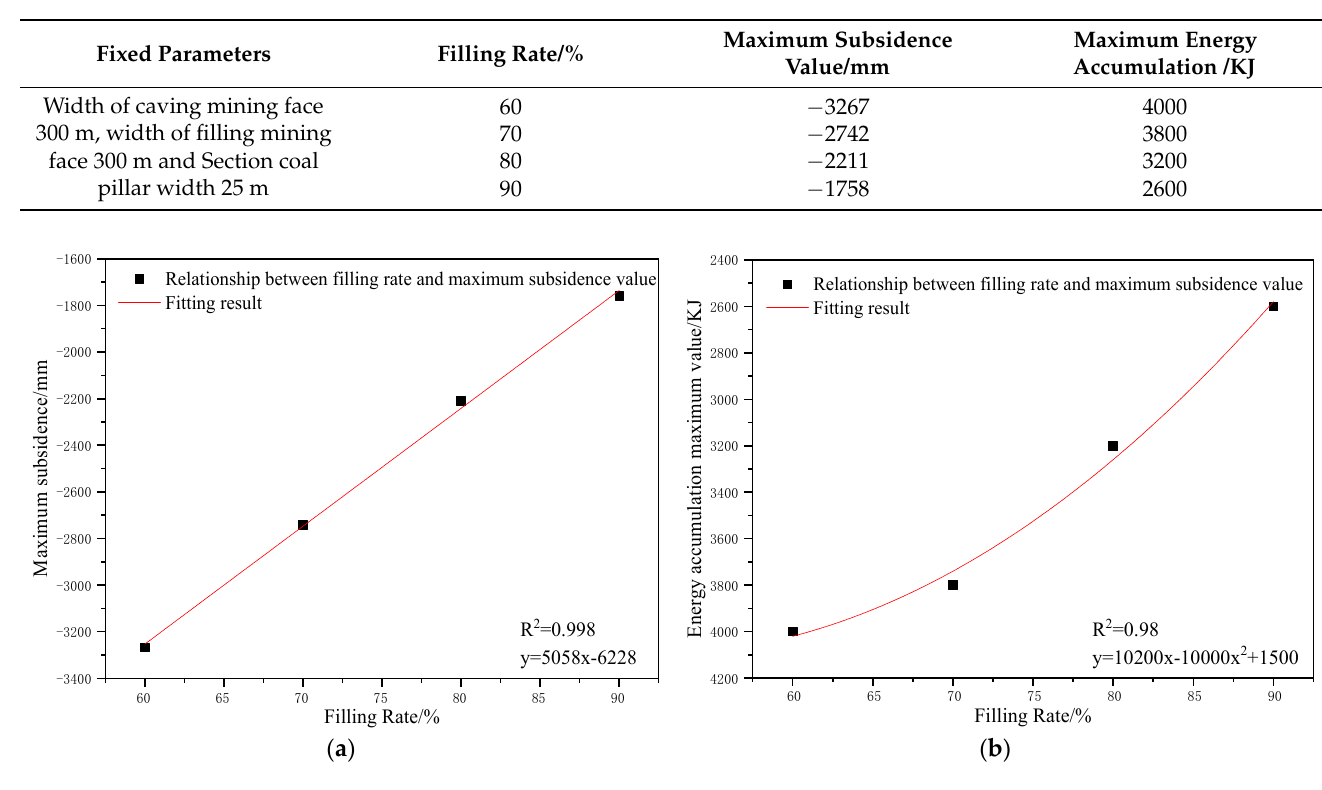
Table 9. Statistics of maximum surface subsidence and maximum energy polling distribution under different filling ratios.